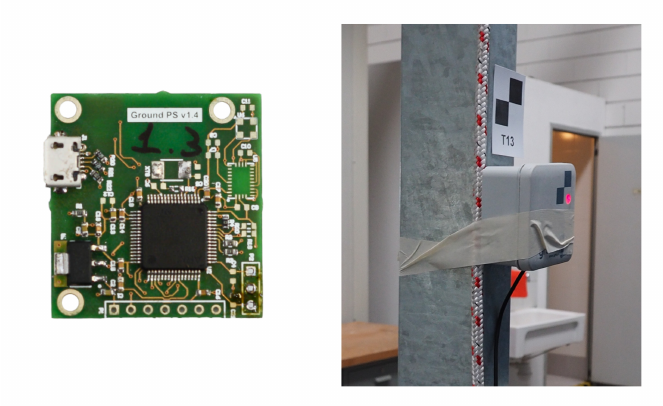
Figure 3. The considered beacon hardware and the experimental setup. The marker on the box represents the reference point for the calibration of the system.